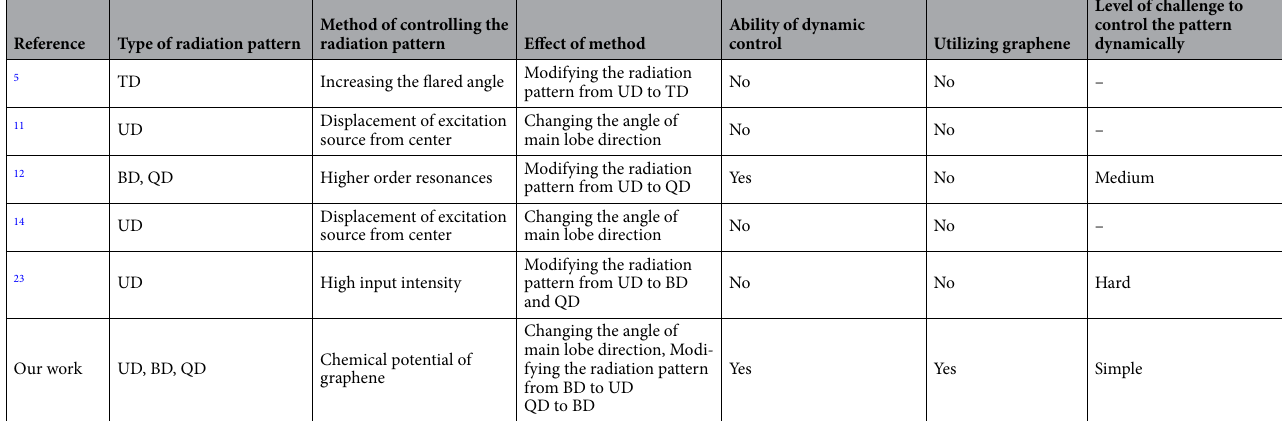
Table 1. Characteristics of our proposed smart OMBNA compared to the previous works at 1550 nm. UD unidirectional, BD bidirectional, QD quad-directional, TD